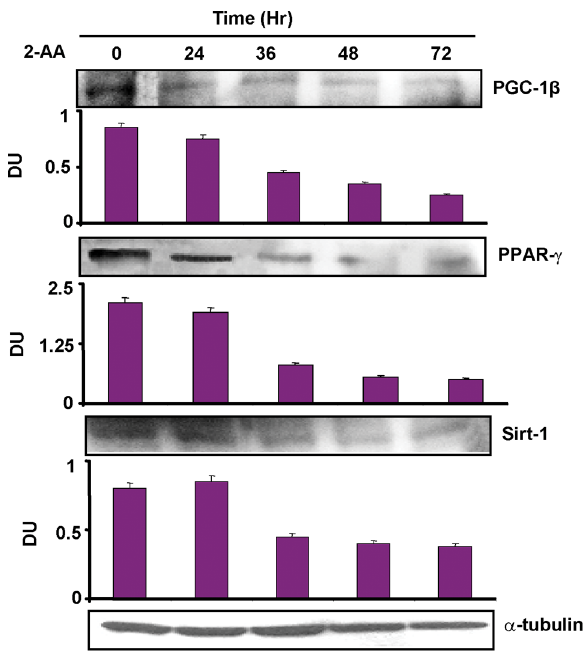
Figure 4. 2-AA treatment dampens key metabolic protein levels in mouse skeletal muscle cells. Western blotting of cellular extracts with specific antibodies of PGC-1 b , PPAR- c and Sirt-1 in 2-AA treated cells at the indicated time points. One representative experiment (out of three) is shown. Loading was normalized relative to mouse a -tubulin. Densitometric data are the average of three replicate experiments and are expressed as mean 6 SD (vertical bars).*p , 0.05 vs. naı¨ve. DU, densitometric units.